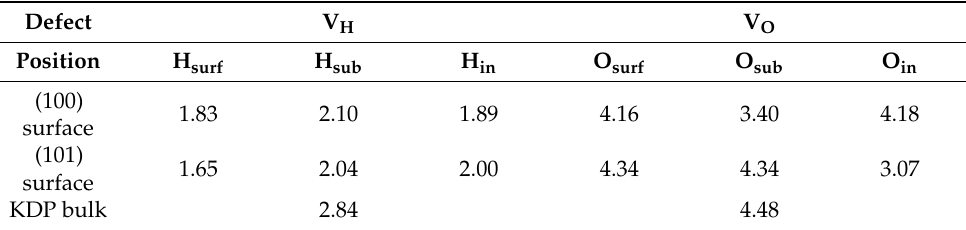
Table 1. Comparison of the formation energies (eV) of V H and V O defects on the surfaces and in the bulk KDP crystal.